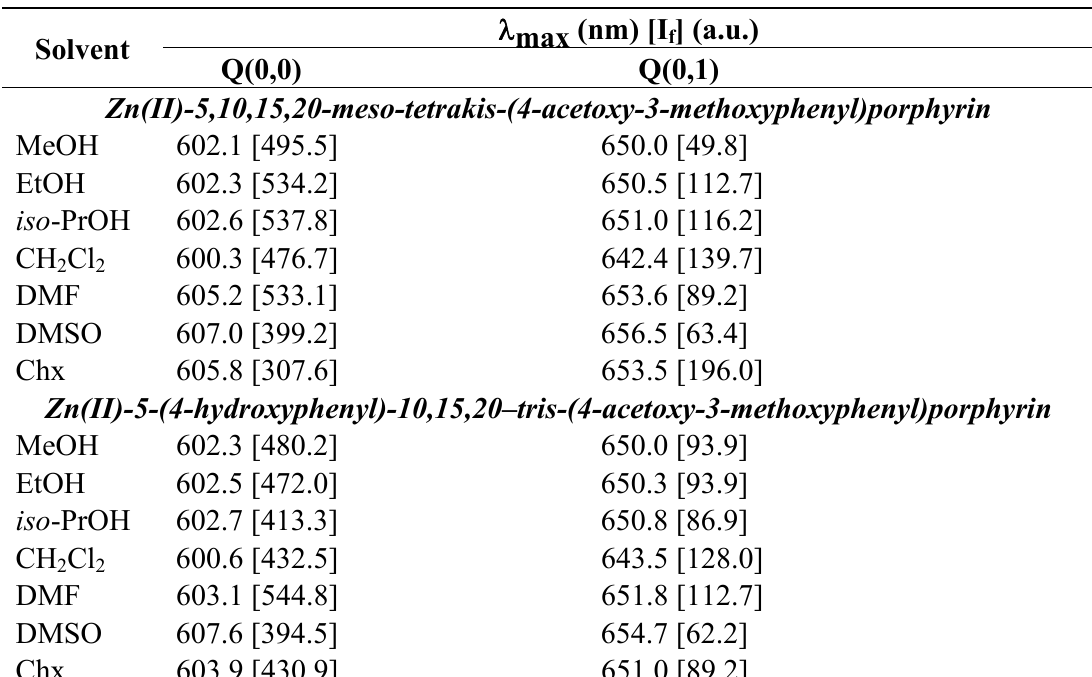
Table 3. The fluorescence data of zinc mesoporphyrinic complexes in different solvents (c = 2.5 × 10 − 6 M, λ = 420 ex